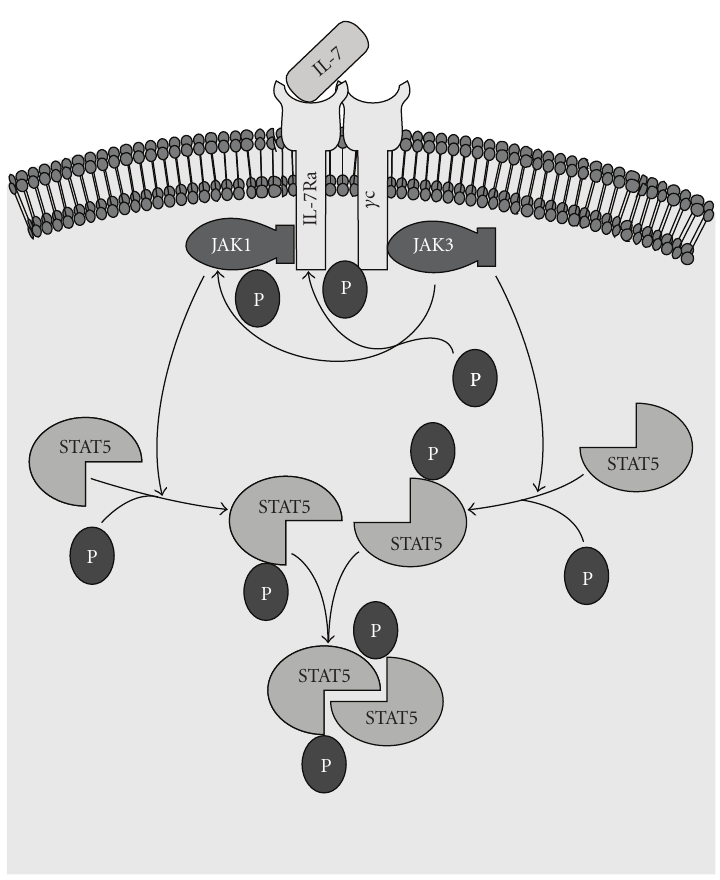
Figure 1: The IL-7/IL-7R Pathway. The IL-7R is composed of a γ C and R α polypeptide. The R α component is unique to the IL-7R, whereas γ C is common to several cytokine-mediated pathways, including IL-2, IL-4, IL-9, IL-15 and IL-21. The binding of IL-7 to R α results in the dimerization of γ C and R α . JAK3 is associated with γ C. After dimerization of γ C with R α , JAK3 can phosphorylate R α and/or JAK1. Activation of JAK3 results in phosphorylation of STAT5. Phosphorylation of STAT5 is required for STAT5 to act as a transcription factor (reviewed in